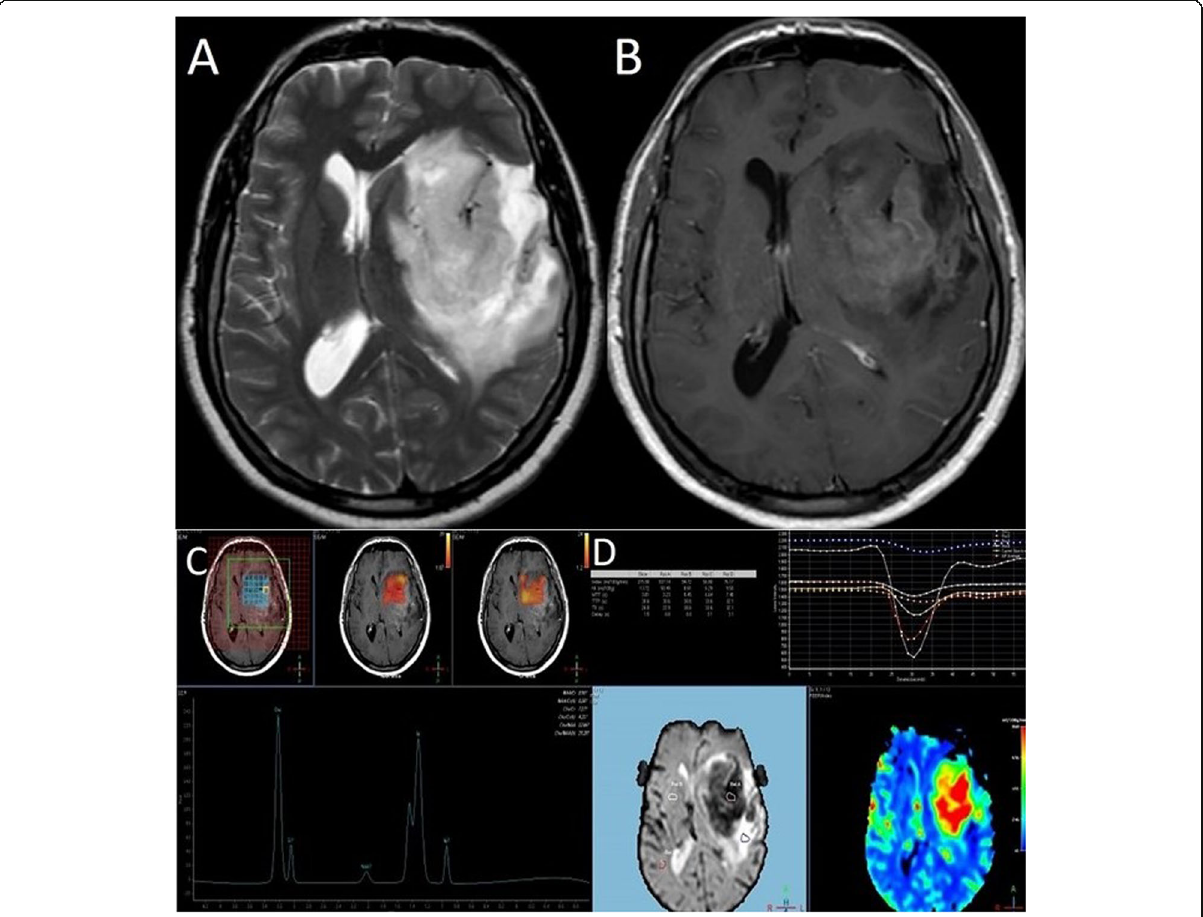
Fig. 1 A 30-year-old male presented by amnesia, slurred speech and right hemiparesis since 1 month. a Axial T2 showing left tempero-parietal large ill-defined SOL surrounded by moderate vasogenic edema. b T1 post Gd showing faint heterogeneous enhancement. c Intermediate echo spectroscopy curve shows Cho/Cr ratio 3.5, Cho/NAA ratio 6, and elevated lactate and lipid peaks. d Perfusion-weighted images PWI and rCBV color perfusion map for the lesion show marked signal drop of the lesion and area of relative hyper-perfusion rCBV5.8, and for the perilesional edema show no signal drop and area of subtle hyper-perfusion rCBV 1.2. Collectively, the findings are in favor of HGG. Histopathological examination confirmed the diagnosis: diffuse anaplastic astrocytoma WHO GRADE